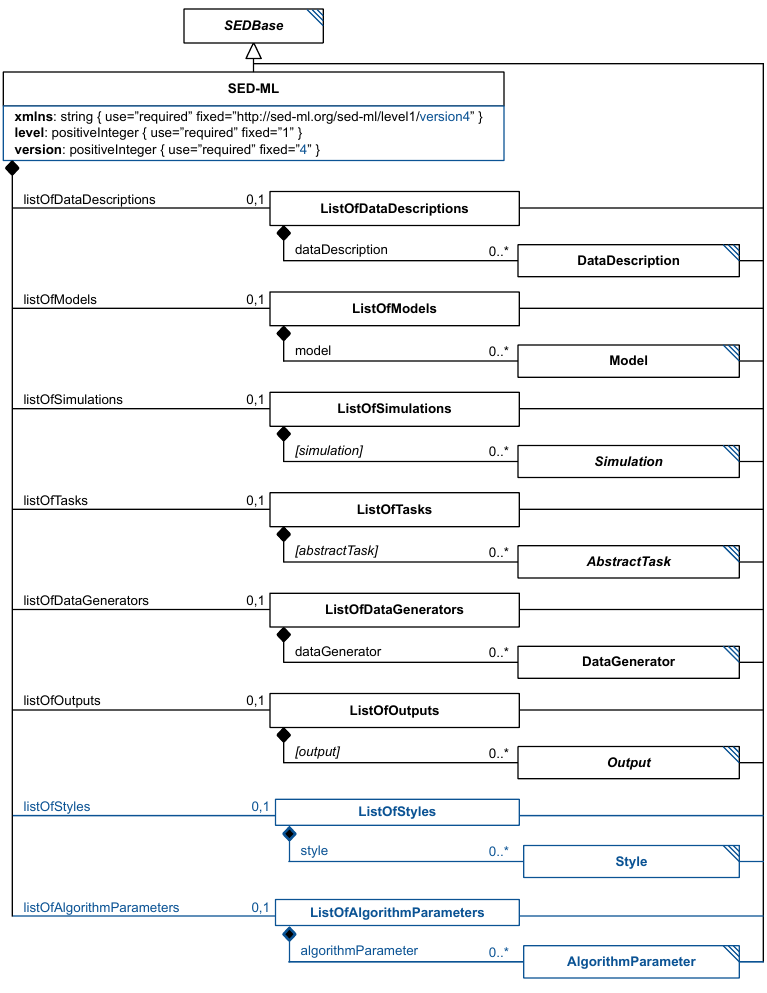
Figure 2.7: The SED-ML